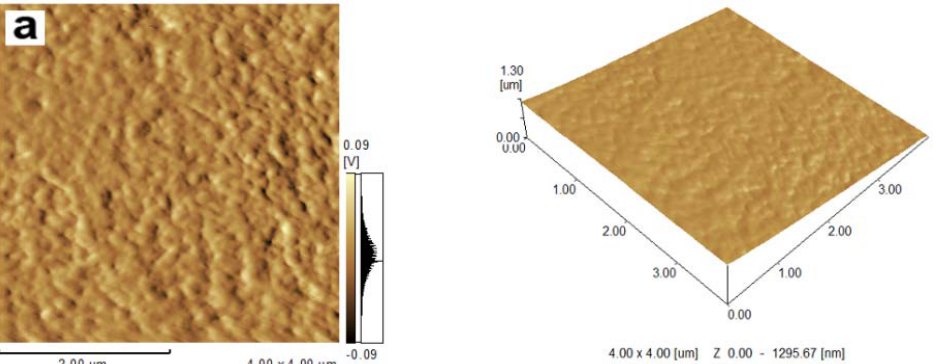
Figure 2. Atomic force microscopy (AFM) images of films: ( a ) control sample; ( b ) cellulose film plasticized with sorbitol; ( c ) cellulose film plasticized with glycerol; ( d ) cellulose film plasticized with